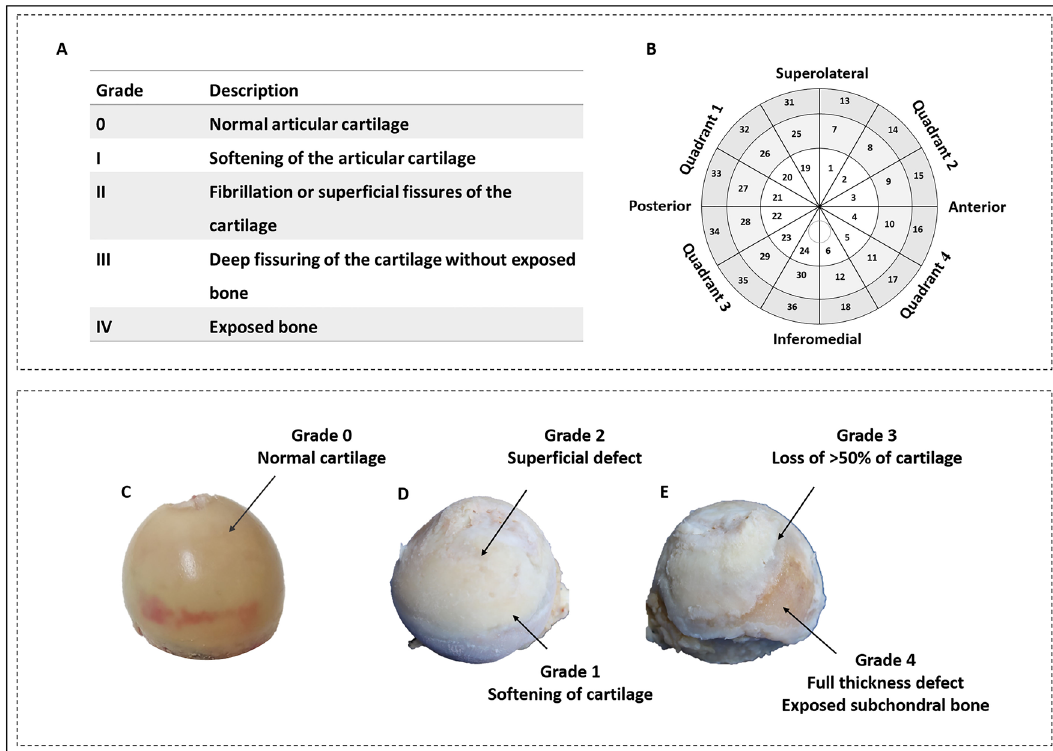
Figure 1. Severity mapping of osteoarthritic femoral heads. ( A ) Outerbridge classification used for grading cartilage lesions. ( B ) Schematic illustration of 36 regions for scoring cartilage lesion severity. ( C – E ) Femoral heads representing cartilage lesion severity of various grades. ( C ) Non-OA femoral head from a 77 year old female patient with normal articular cartilage. OA femoral head from a 52 year old female patient representing grades 1 and 2 ( D ), and 3 and 4 ( E